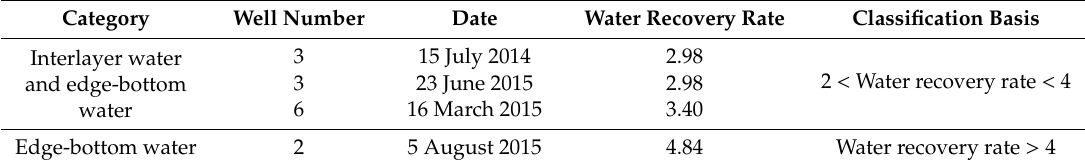
Table 10. Source category of formation